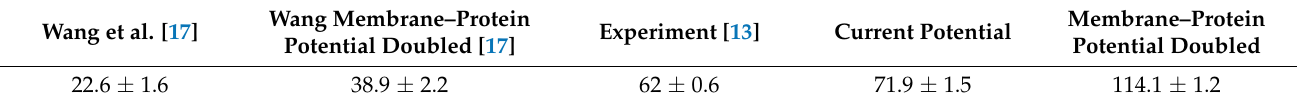
Table 2. Helix A’s average rupture force [pN].